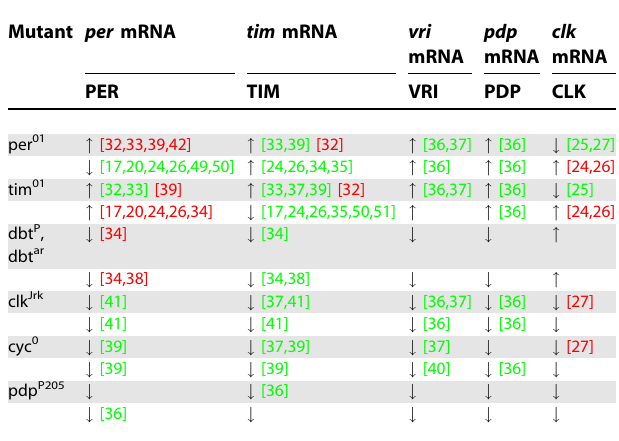
Table 1. Comparison of Experimental Homozygous Arrhythmic